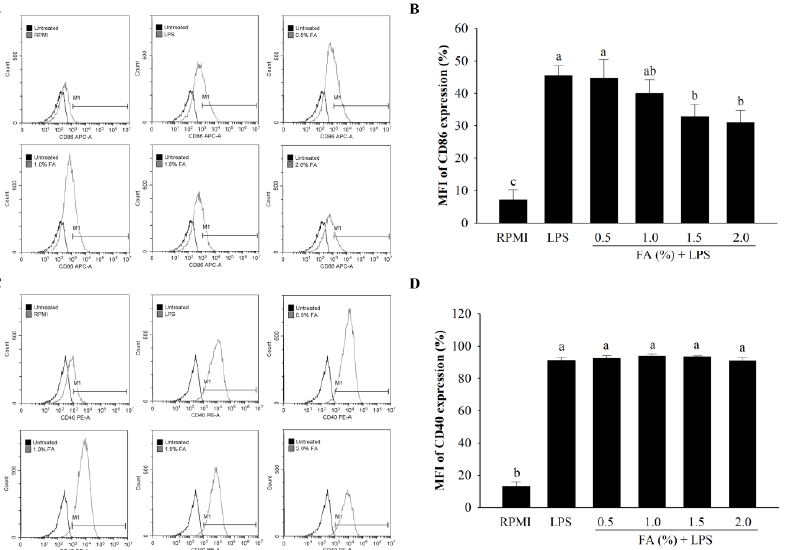
Figure 6. The effect of HAGF on the cell surface molecule expression. ( A ) CD86 expression fluores- cence histograms. ( B ) Mean fluorescence intensity (MFI) of CD86 expression. ( C ) CD40 expression fluorescence histograms. ( D ) MFI of CD40 expression. Values are shown as means ± SD ( n = 3). Different letters (a–c) are used to reflect statistical differences at p < 0.05. M1 = An immune stimulation activity-related macrophage phenotype. FA = fatty acid.